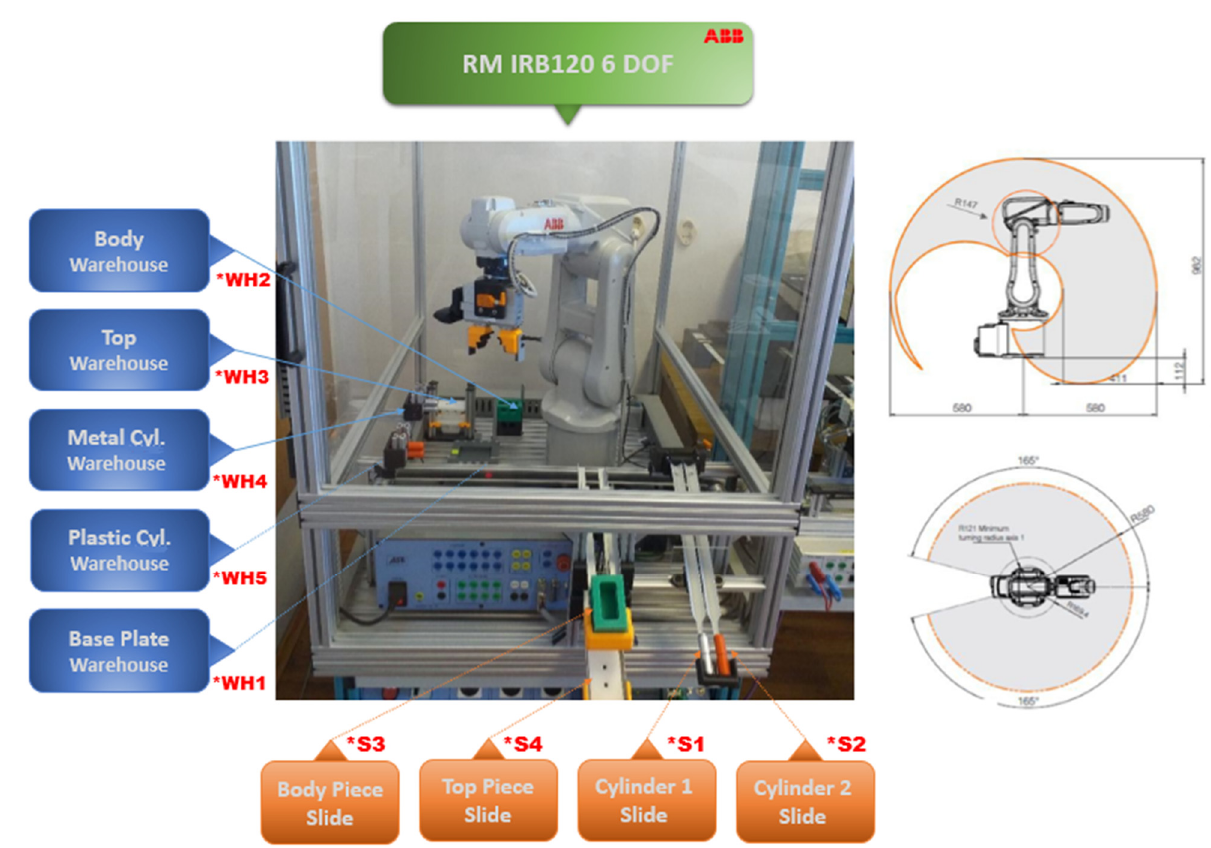
Figure 3. Flexible Cell Station with RM ABB IRB120 6-DOF.